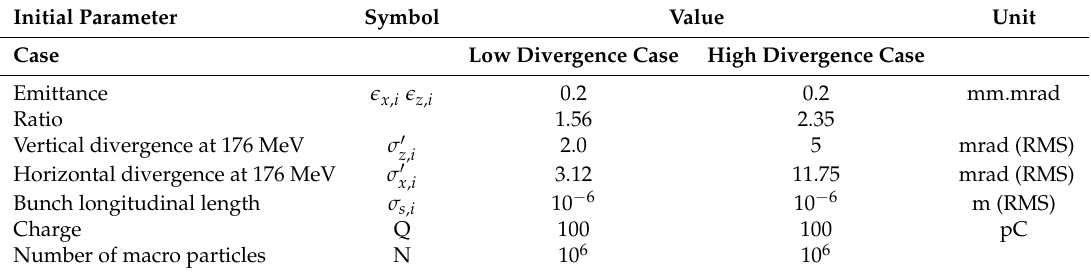
Figure 2. Initial beam electron distribution ( black ), vertical ( blue ), and horizontal ( red ) divergence. ( a ) Low divergence beam (average over a set of 20 distributions), ( b ) high divergence beam (single-shot). Table 1. Initial input beam